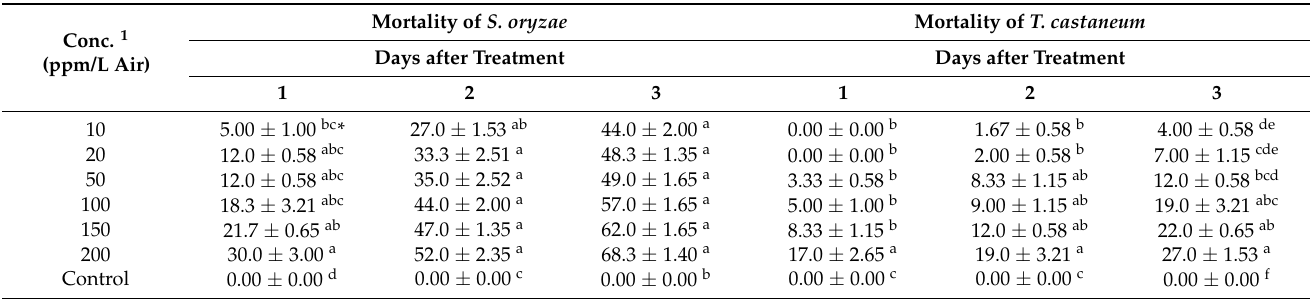
Table 6. Mortality ( ± SD) of S. oryzae and T. castaneum adults following the fumigation bioassay of S. chinensis